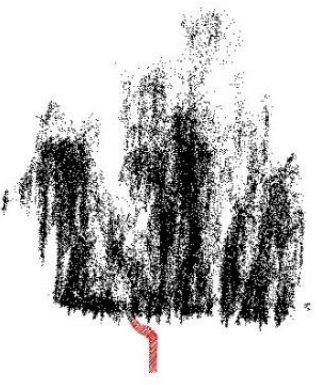
Figure 16. Results of tree trunk bending (the red points represent tree trunk points extracted by our method).